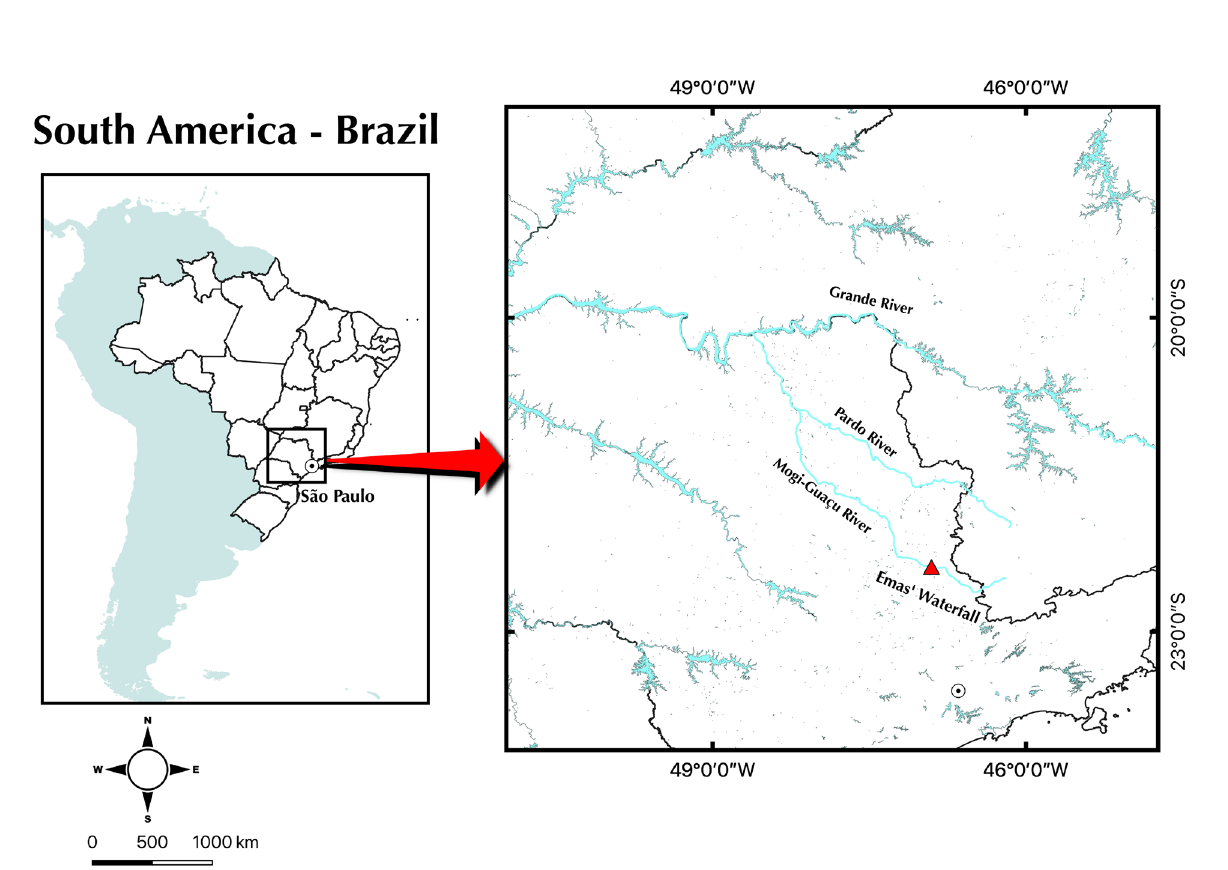
FIGURE 1 | Map of the State of Sao Paulo showing the main components of the hydrographic system in the Southeast of Brazil. In detail square, the collection site of samples located in Cachoeira de Emas, Pirassununga-SP. The Mogi-Guaçu River is a component of the Upper Paraná River